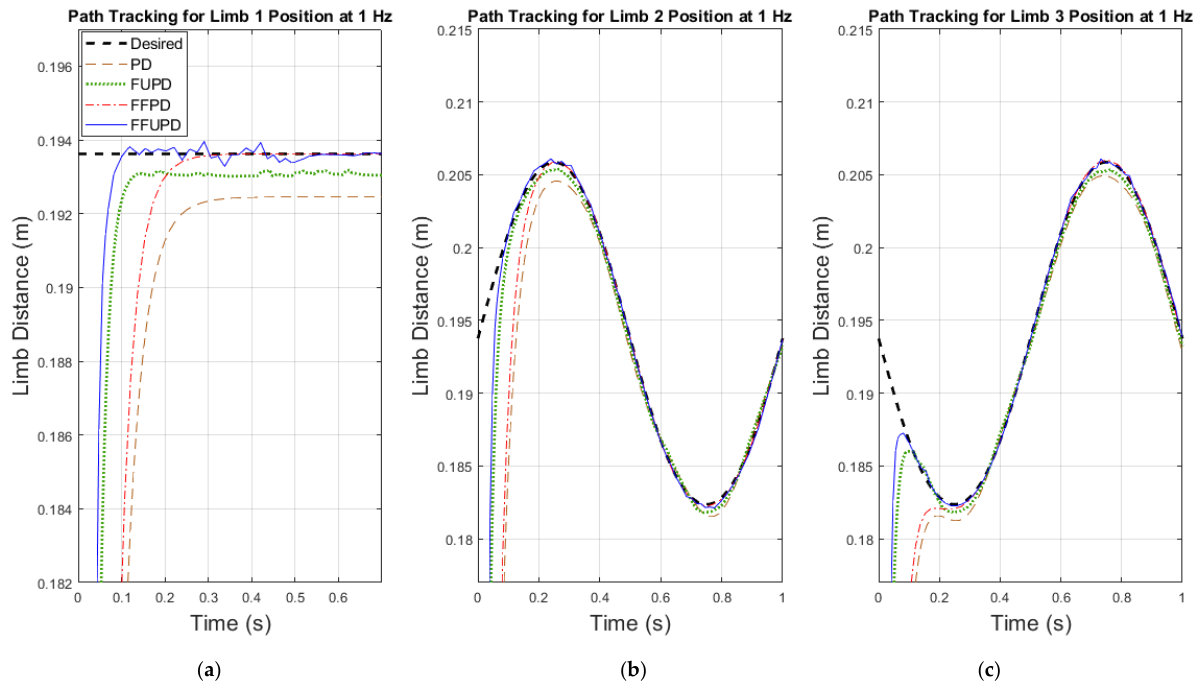
Figure 10. Results for set 1 of simulations at 1 Hz: ( a ) shows steady-state error from PD and FUPD and great performance to reach position from FFPD and FFUPD, ( b ) shows great response to follow desired trajectories in limb 2 and ( c ) limb 3 seems to reach positions with either controller.